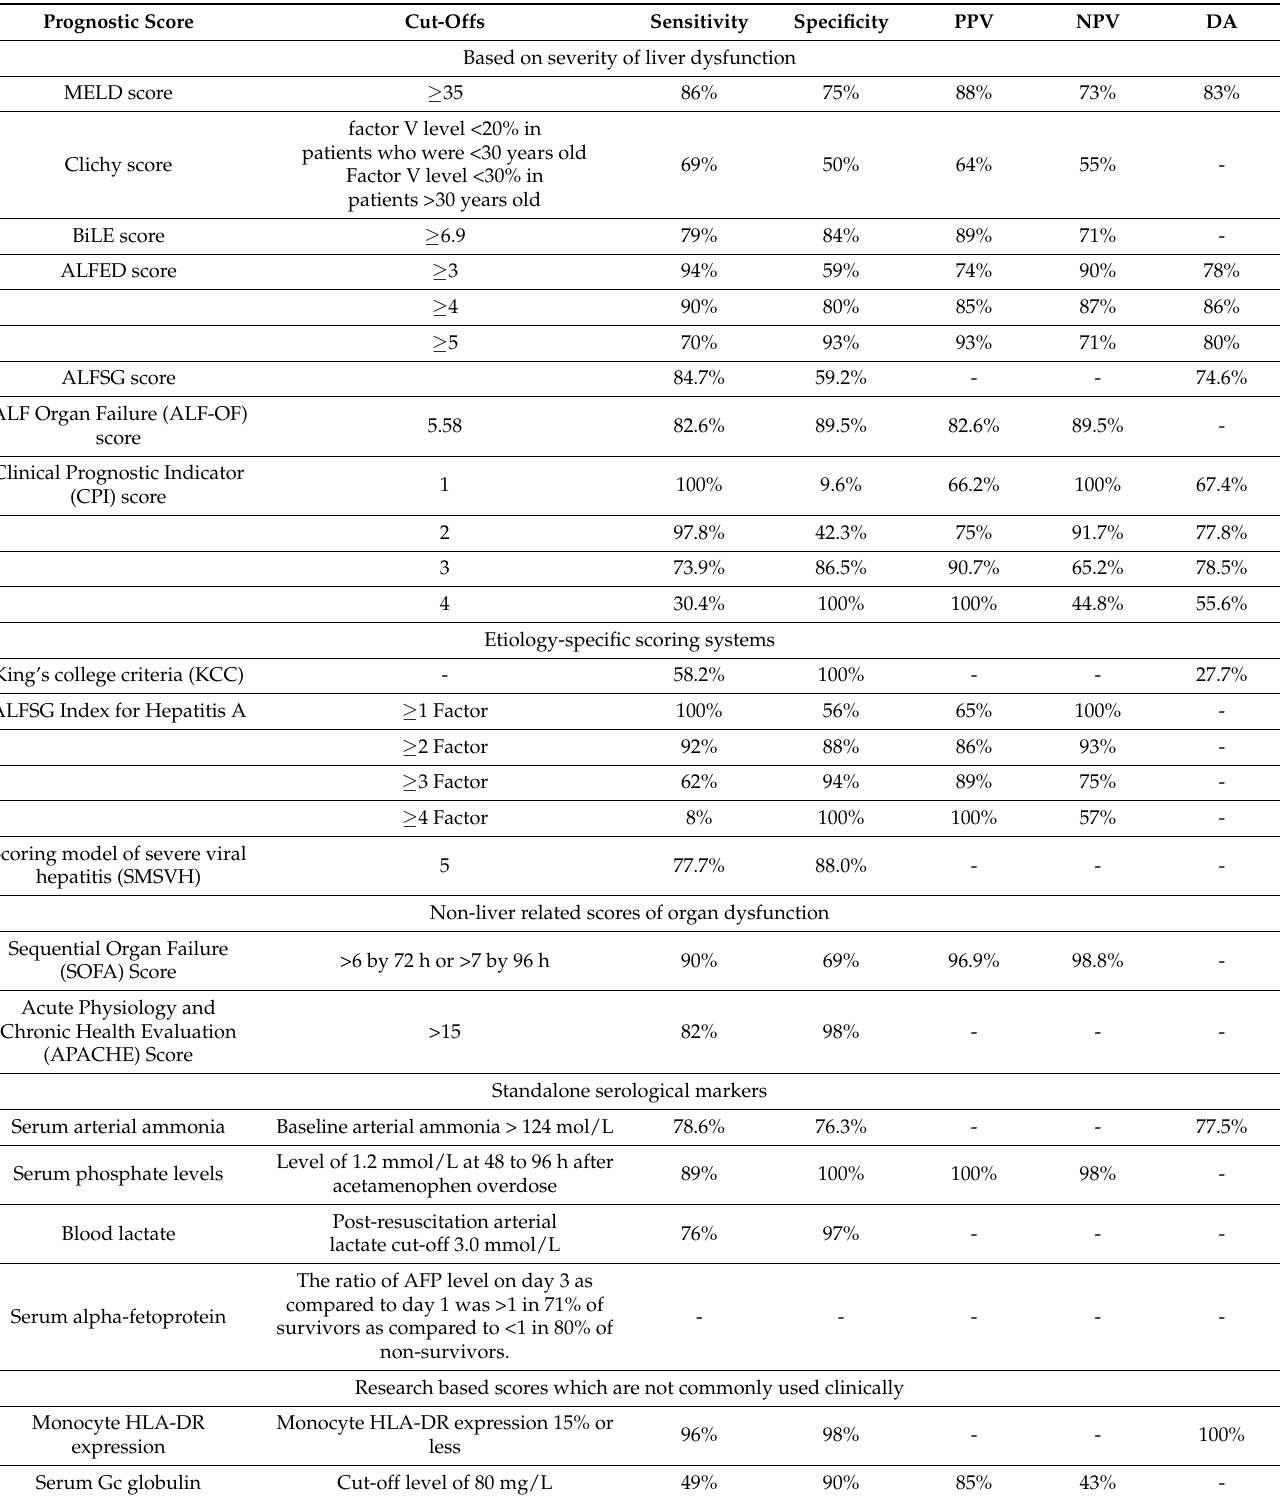
Table 6. Utility of prognostic scores in predicting mortality/outcome in patients with